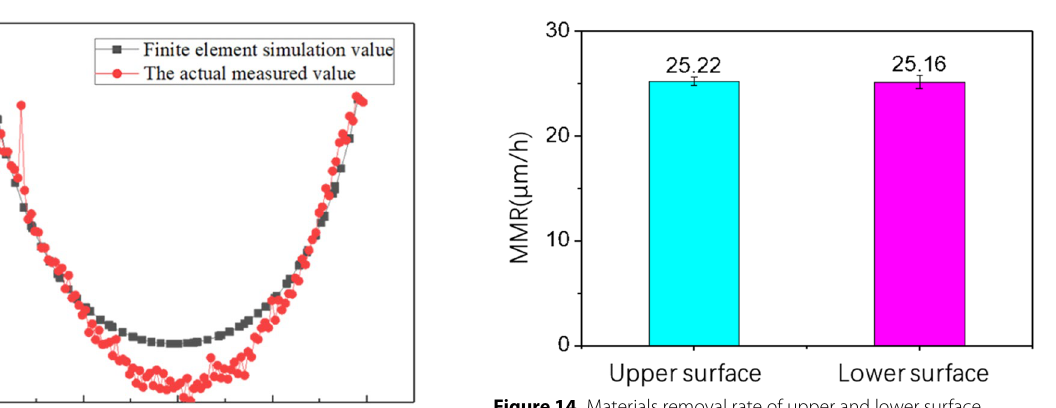
Table 3 Comparisons between experimental and simulated values of machining deformation